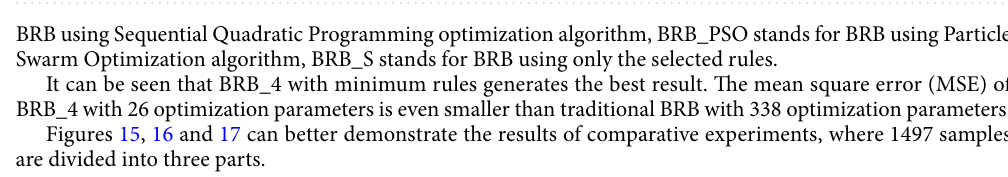
Figure 8. The 1001–1500 comparative results generated by different